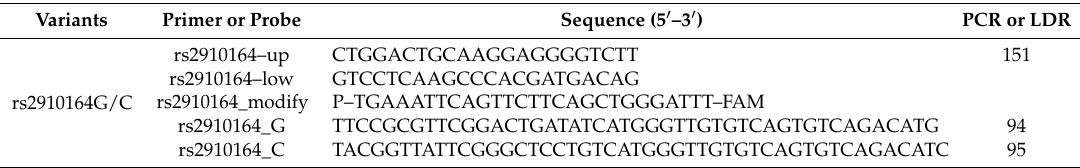
Table 6. Primer or probe sequences and PCR or LDR product length of rs2910164.